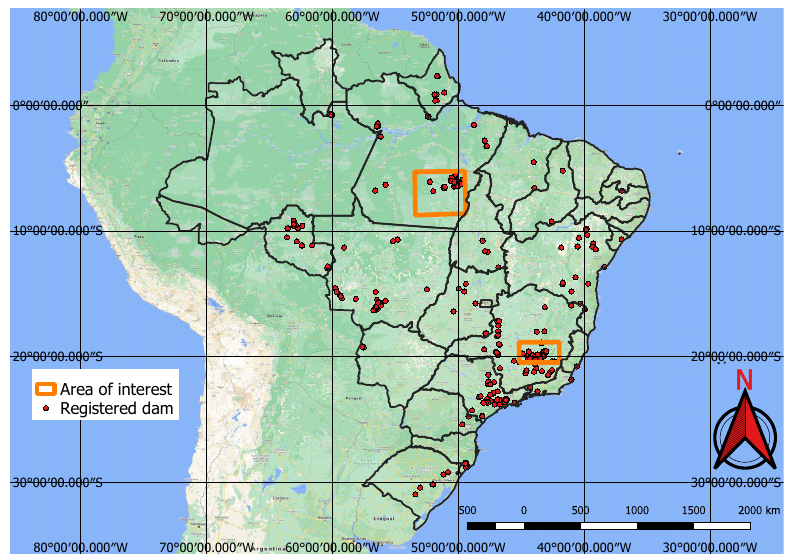
Figure 10. Areas of interest: Minas Gerais (south) and Para (north).